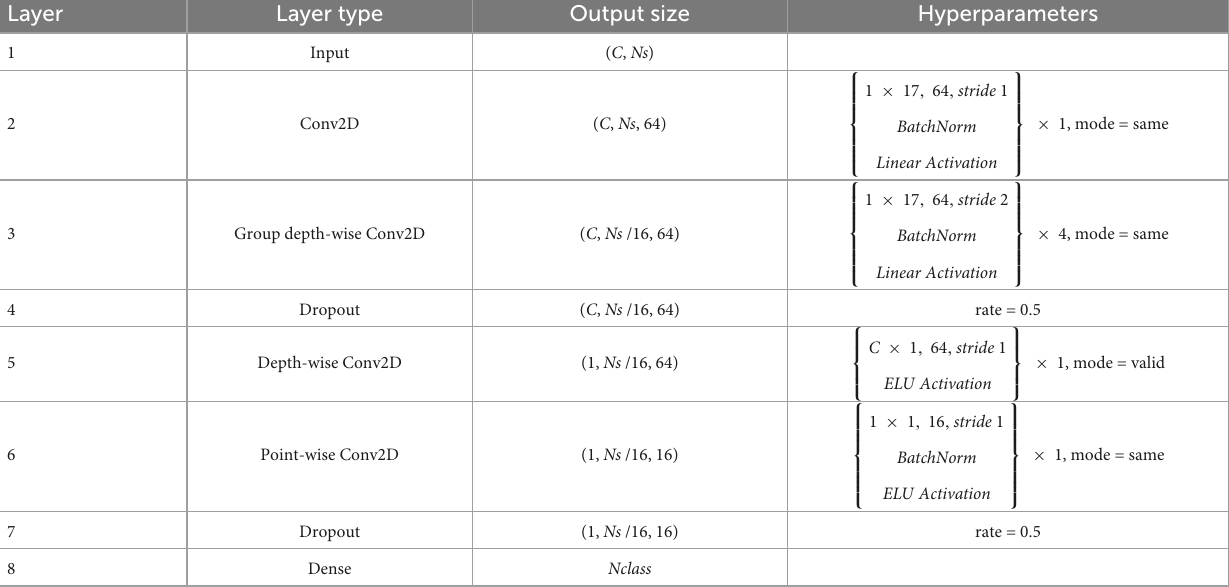
TABLE 1 Specific parameters setting in the GDNet-EEG model, where C means the number of EEG channels, T denotes the number of time points, and N indicates the number of SSVEP stimulation frequencies. Layer Layer type Output size